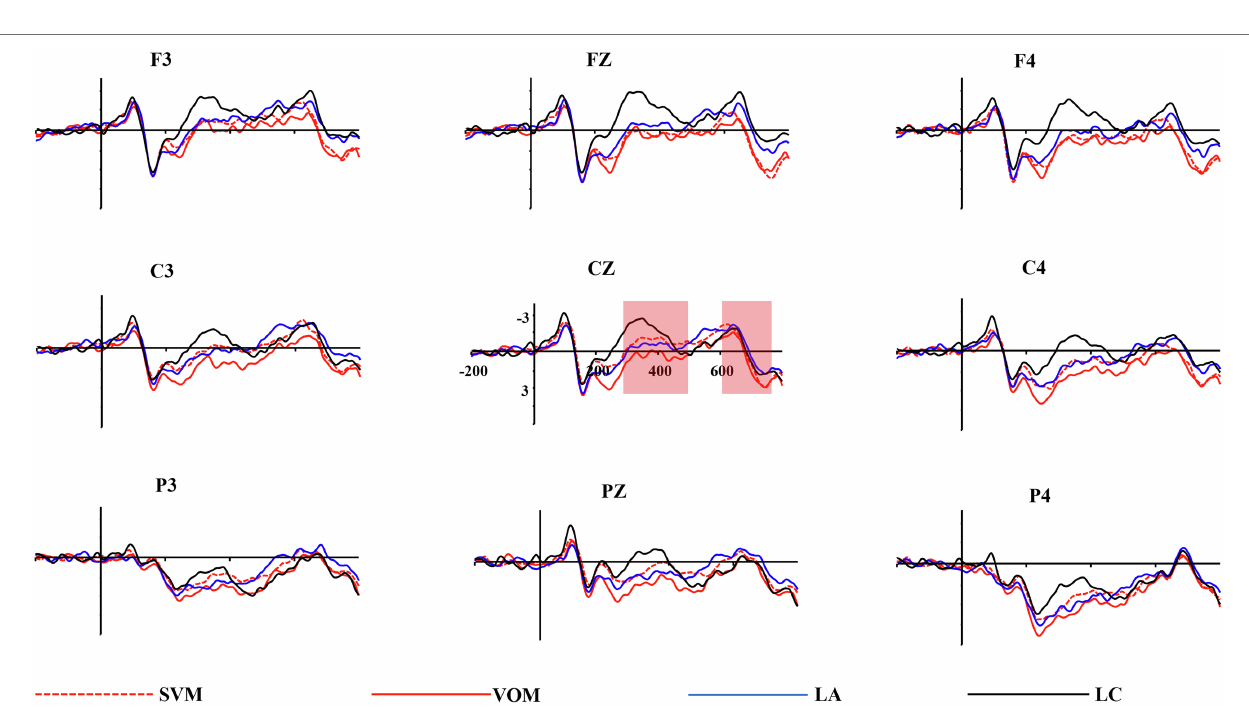
FIGURE 3 | Grand average ERP waveforms recorded at object for the chosen